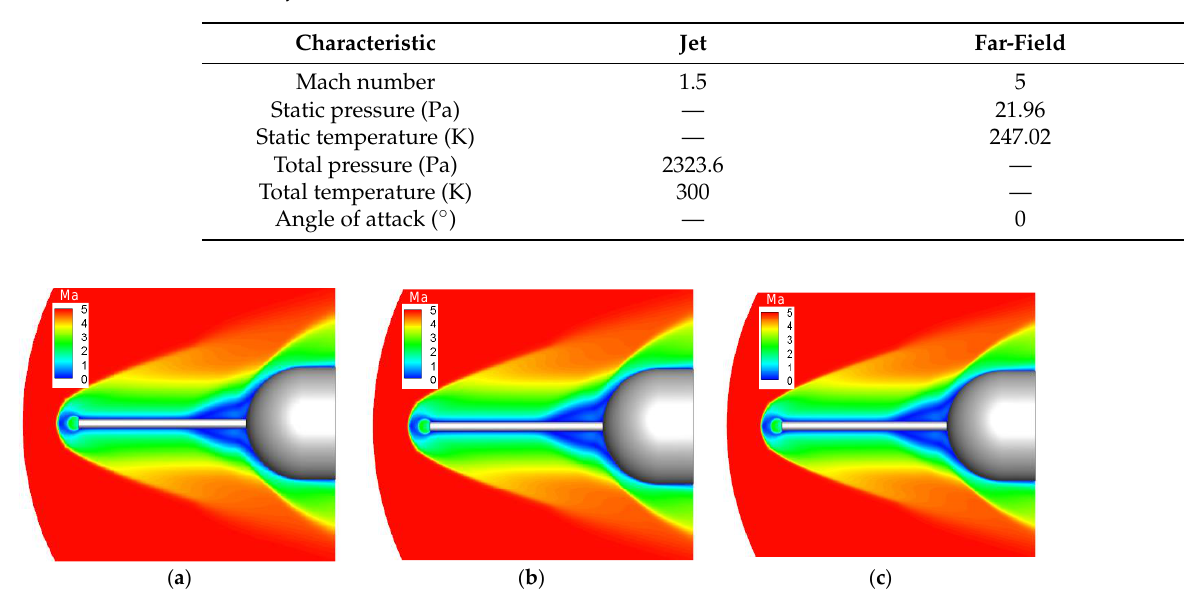
Figure 4. Heat flux distribution of nose cone. Table 3. Total heat flux and peak heat flux. Grid